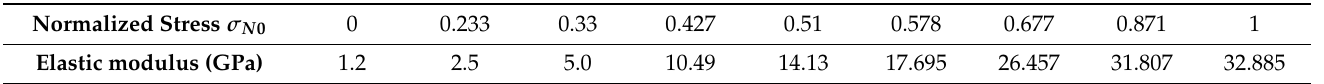
Table 2. Relationship between normalized stress and elastic